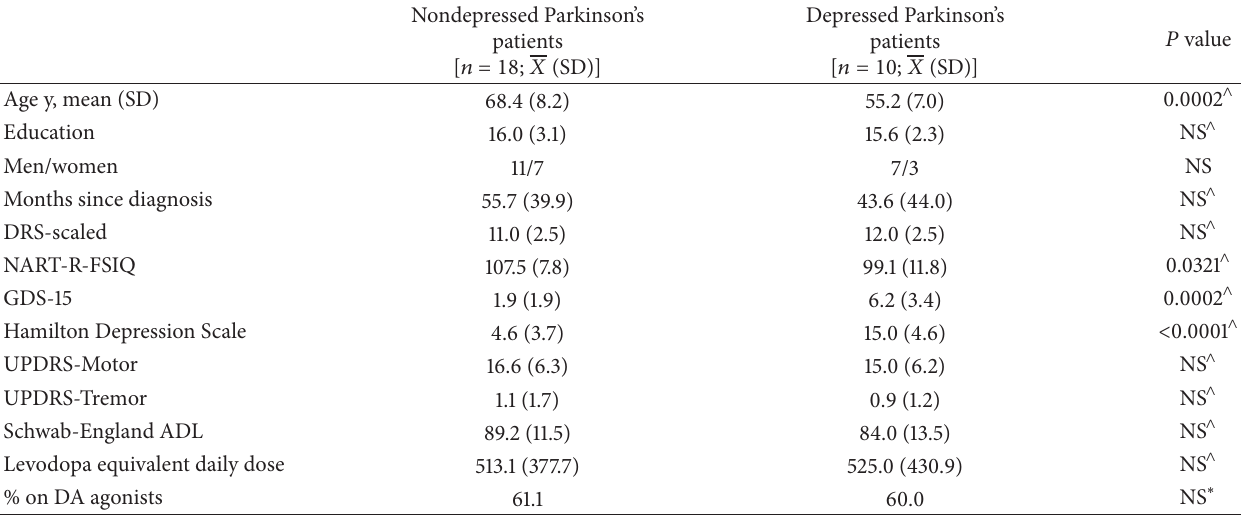
Table 1: Demographic and clinical data (on PD